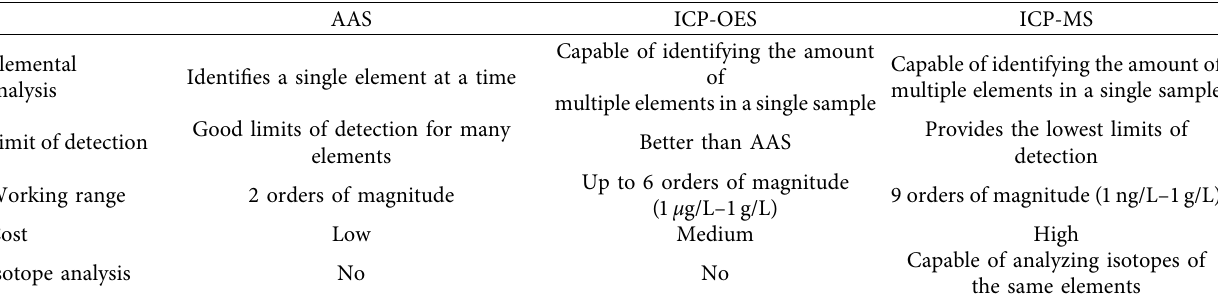
Figure 1: ICP-MS system composition. Table 1: Comparison between OES, AAS, and ICP-MS